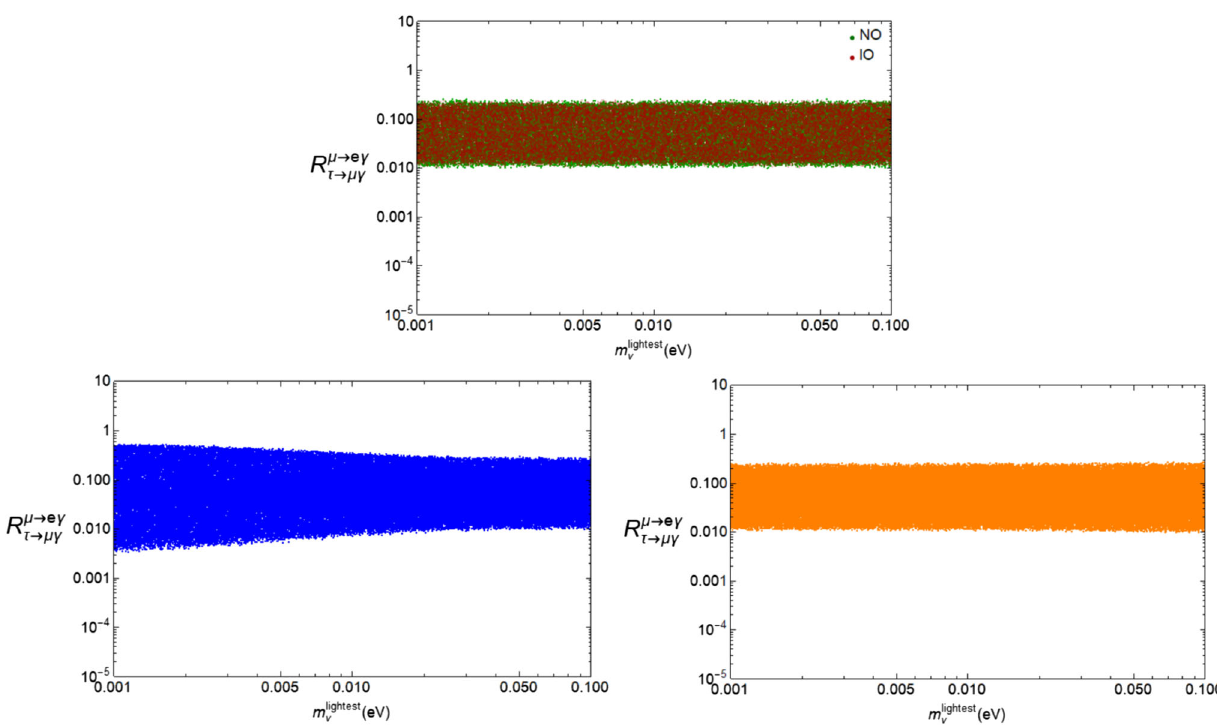
μ e Fig. 1 R τμ for MFC (upper plot) and EFC (lower plots) as a function of the lightest neutrino mass. In the upper plot, neutrino NO is in green while IO is in red. The lower left plot refers to NO, while the lower right to IO